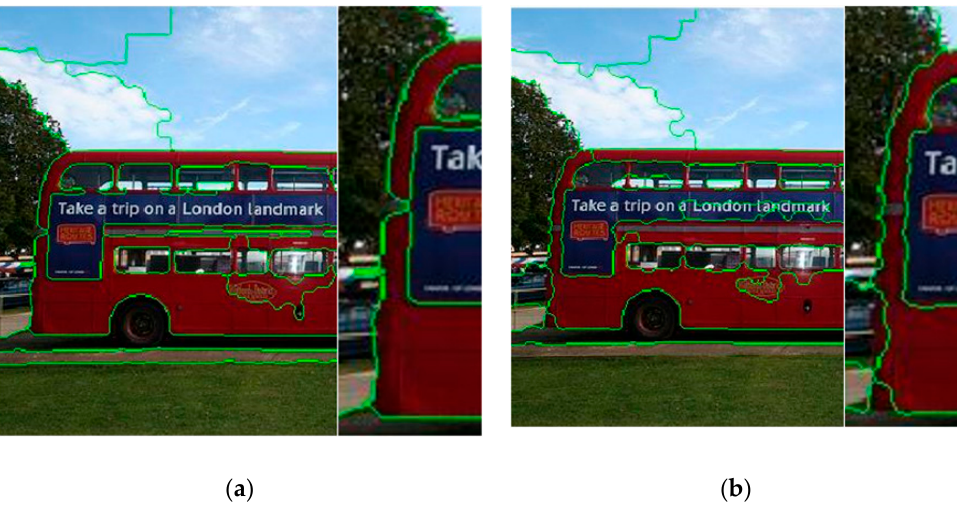
Figure 3. The region merge graph of Simple Linear Iterative Clustering (SLIC) and zero parameter version of SLIC (SLICO). ( a ) is the magnified regions of SLIC, ( b ) is the magnified regions of SLICO. The figure shows the effect of boundary term.